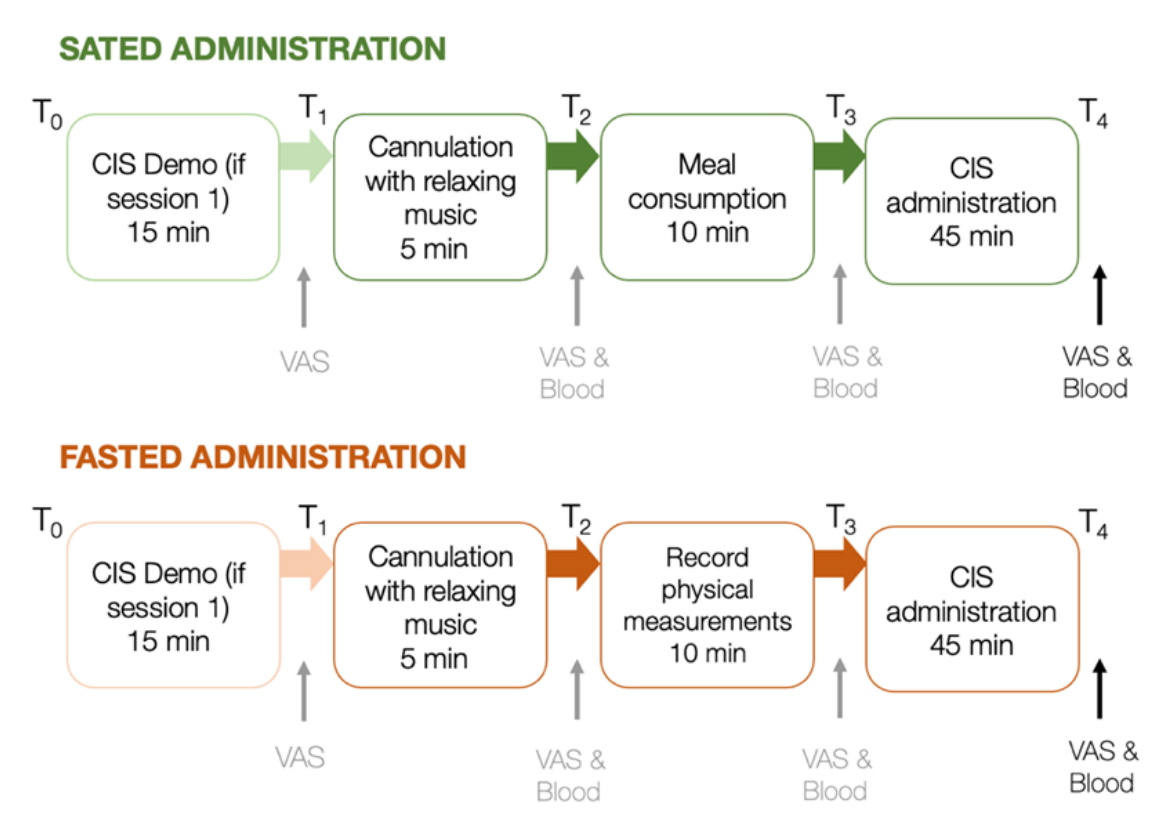
Figure 2. Procedure of laboratory protocol for sated and fasted sessions, scheduled 7–10 days apart. VAS and blood samples are taken at points indicated. VAS and blood data assessed at the last time point of each session were considered for further analyses. min = minutes; ↑ indicates the administration of VAS and/or blood samples between key steps in the testing protocol.